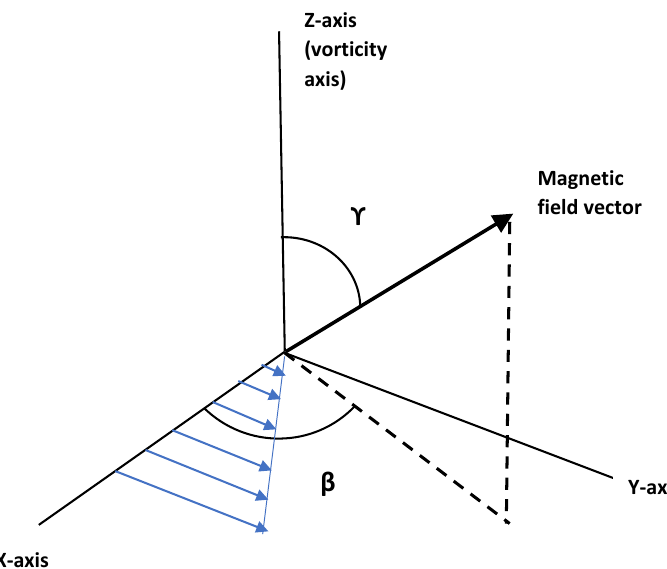
 Figure 26. Coordinate system. The magnetic field has a polar angle of γ and an azimuthal angle of β Figure 26. Coordinate system. The magnetic field has a polar angle of and an azimuthal angle of  . Unlike suspensions of spherical magnetic particles, the rheological properties of non-spherical magnetic particles depend on both polar and azimuthal angles of the external magnetic field.